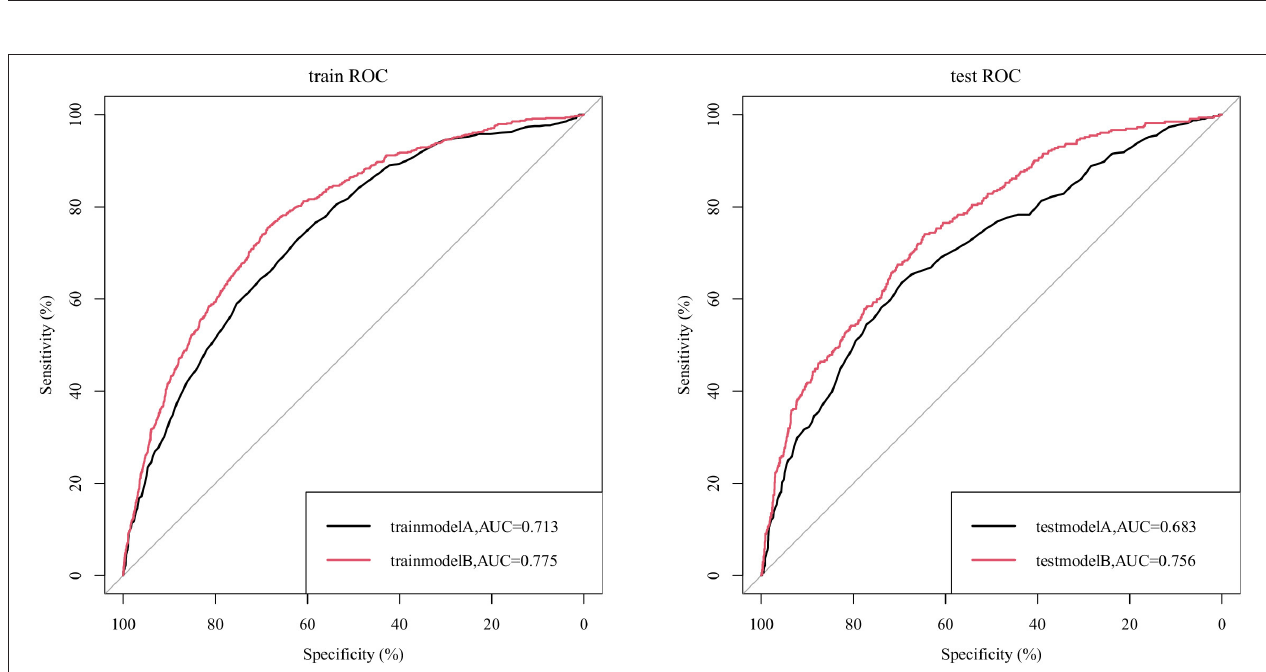
FIGURE 2 | ROC curves for the APSIII model (model A) and the nomogram (model B).